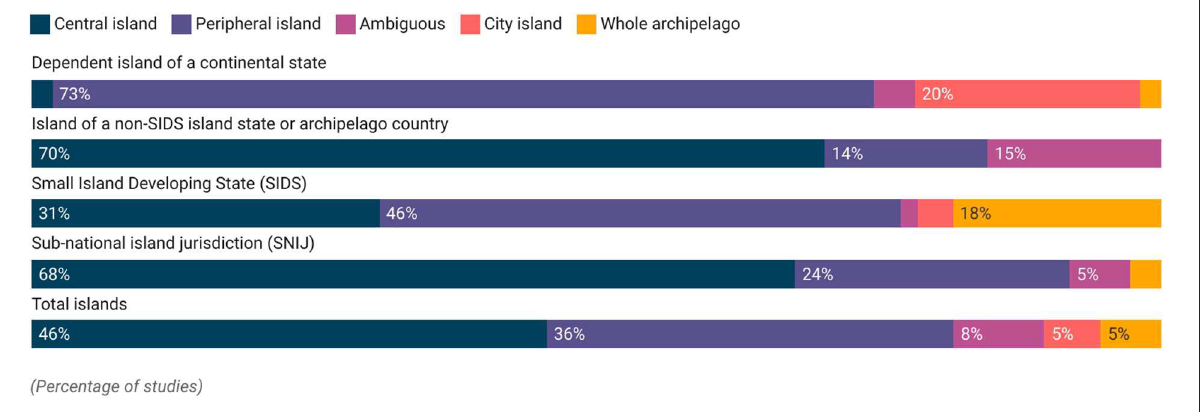
FIGURE5 Distribution of island types across island case studies.